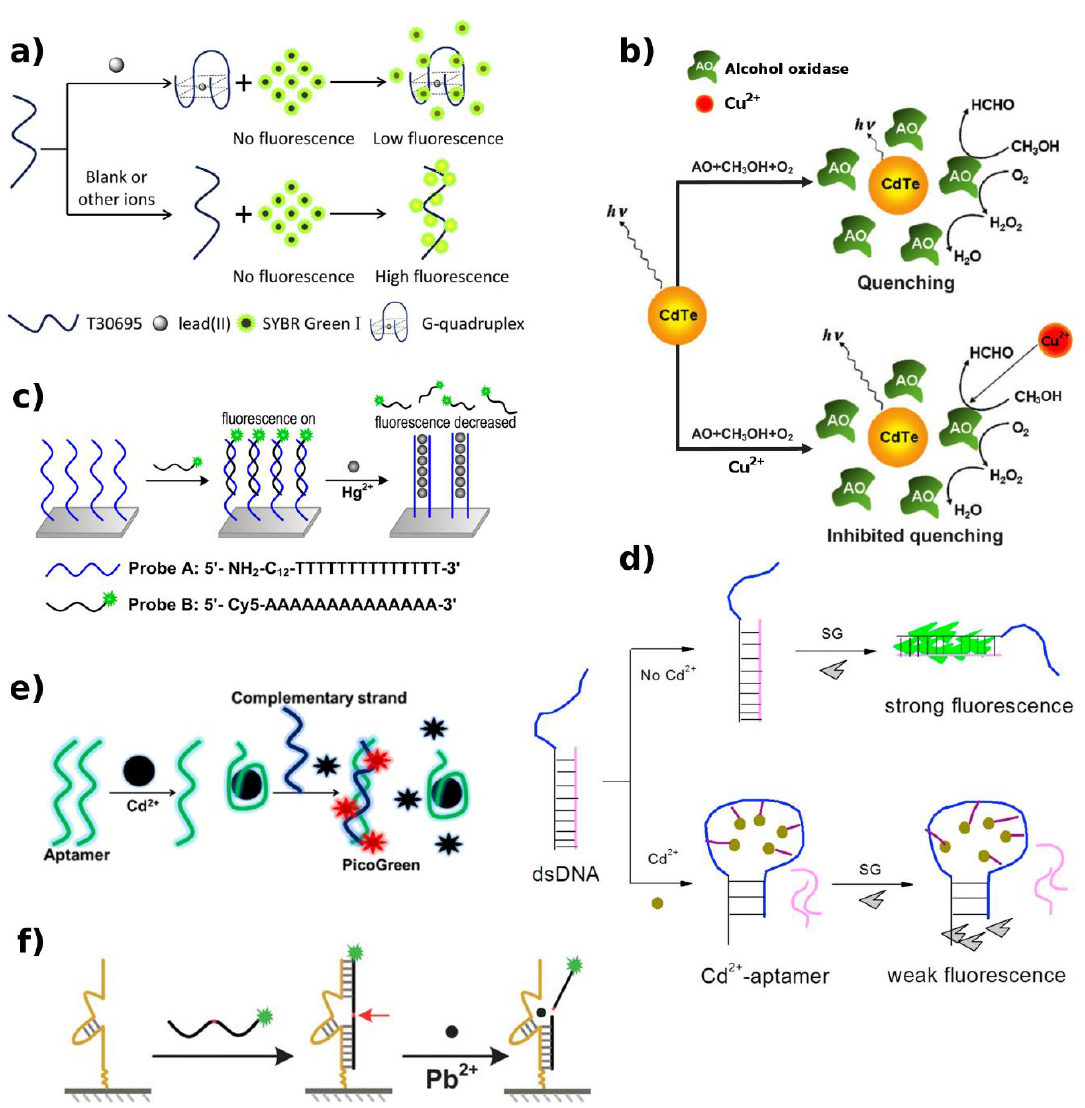
Figure 4. Various biosensing element constructs for fluorescence-based HM detection. ( a ) Pb 2 + -stabilized G4 formation for turn o ff detection. In the presence of Pb 2 + , the T30695 oligonucleotide folds into a G4 structure, leading to a PL signal reduction [64]. ( b ) Cu 2 + -determined enzymatic inhibition for turn on detection. AO catalyzes the oxidation of methanol to hydrogen peroxide, inducing the quenching of QDs fluorescence. Cu 2 + ions inhibits the enzymatic activity decreasing the quenching of QDs fluorescence [48]. ( c ) Metallophilic attraction of the Hg atom in the T–Hg 2 + –T base pair mismatch. The Hg 2 + -induced dislocation of the complementary labeled poly–A strand allows the turn-o ff detection mechanism. [51]. ( d ) Cd 2 + -induced hairpin formation. The release of the complementary strand from dsDNA and the sequence conformational switching to a stem-loop structure lead to a fluorescence decay of the signal reporter [73]. ( e ) Random coil structure to aptamer–Cd 2 + complex. After the addition of complementary strands and PG, the residual free aptamer that did not bind with Cd 2 + forms a hybrid with complementary strands and PG dye which results in a big fluorescent enhancement [72]. ( f ) Pb 2 + -induced hydrolytic cleavage signal-o ff . The catalytic strand carries out catalytic reactions for hydrolytic scission of the substrate sequence at the rA site (red arrow). Once the substrate is broken into two pieces, it dissociates from the catalytic strand with a decrease of the surface PL intensities [54]. Adapted with the permission of the Publishers.